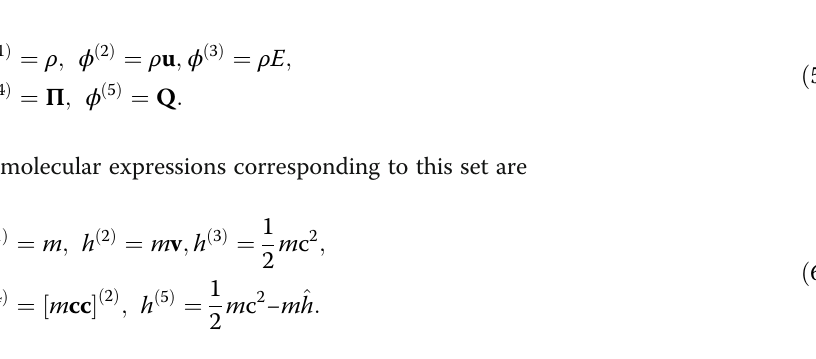
^ h are the molecular mass, peculiar velocity of the molecule, and en- where, m , c , and thalpy density per unit mass, respectively. The symbol [] (2) denotes the traceless sym- metric part of the second rank tensor. The viscous shear stress Π is related to the stress tensor P through the relationship